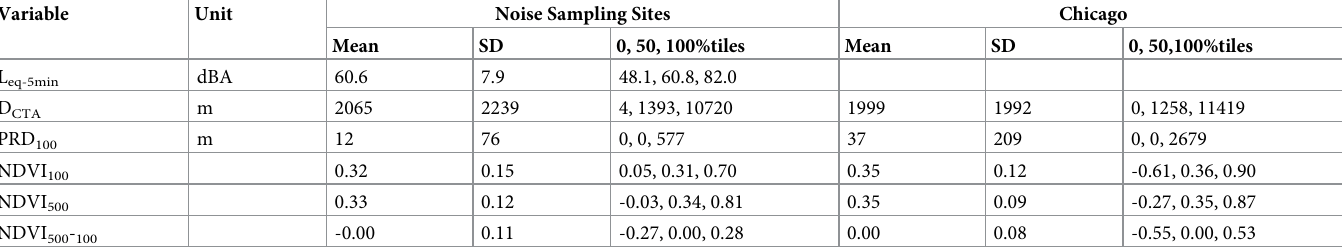
Table 1. Measured noise levels (L eq-5min ) and geographically-based variables included in the final land use regression model at the noise sampling sites (n = 75) and at the centroids of the census blocks in Chicago, IL (n = 46,375). Variable